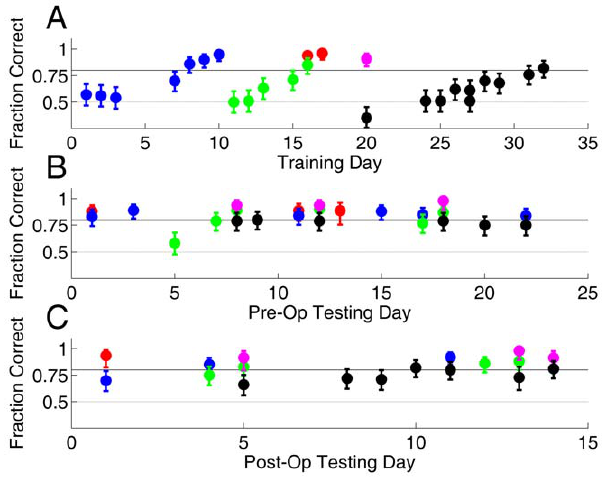
Figure 5. Performance on visual tasks: subject S2. Symbol colors and error bars as defined in Figure 2. A. Task acquisition. This subject had learned an Approach Visual Target task previously (not shown). B. Stability of performance on visual tasks immediately after acquisition and before surgery. C. Post-operative performance after medial extrastriate lesion. No behavioral deficits were observed for approach- ing salient visual targets (red, magenta), image discrimination (blue), random dot motion discrimination (green), or orientation discrimination (black).